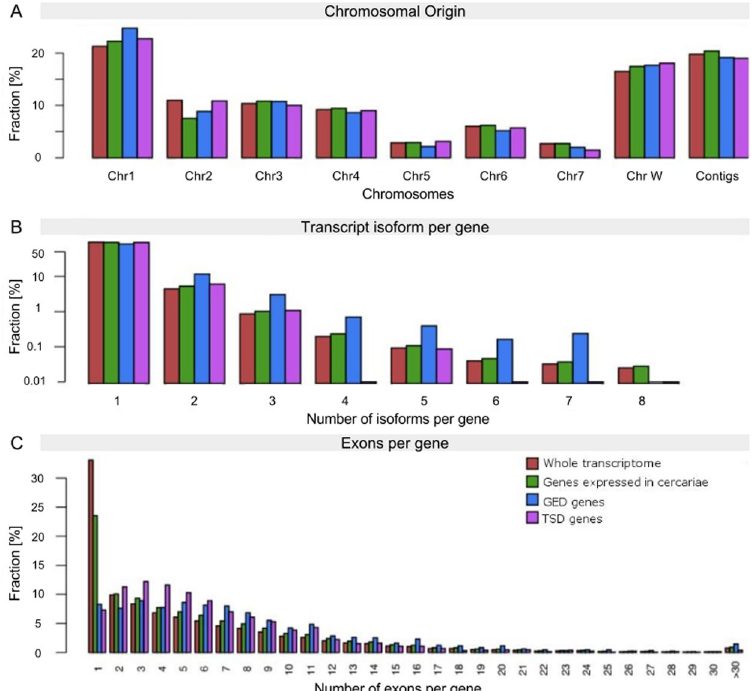
Figure 4. Chromosomal origin, alternative splicing isoforms and number of exons in the trans-spliced genes. ( A ) The relative distribution of trans-spliced genes with high expression levels (GED, blue bars) and trans-spliced genes with low expression levels (TSD, purple bars) in each chromosome is compared with the chromosome distribution of genes expressed on the S. mansoni whole transcriptome (red bars) and genes expressed only in the cercariae transcriptome (green bars). ( B ) The relative distribution of alternative splicing transcript isoforms per gene in the S. mansoni whole transcriptome, in the cercariae transcriptome, in the subset of GED genes and in the subset of TSD genes. ( C ) The relative distribution of transcripts from genes with single or multiple exons in the S. mansoni whole transcriptome, in the cercariae transcriptome, in the subset of GED genes and in the subset of TSD